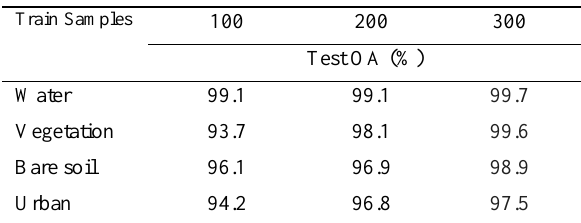
Table 5. Obtained classification results of every class for different training sizes for the proposed 2-D